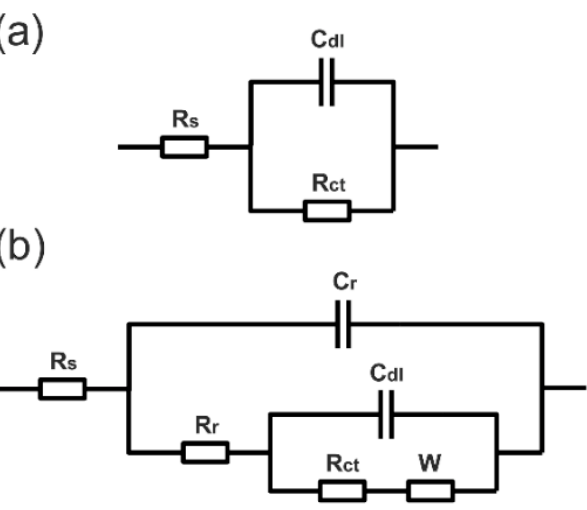
Figure 10. Equivalent circuits of naked ( a ) and rusted ( b ) archaeological iron in simulated seawater. Table 1. Fitting data of impedance parameters in equivalent circuits.